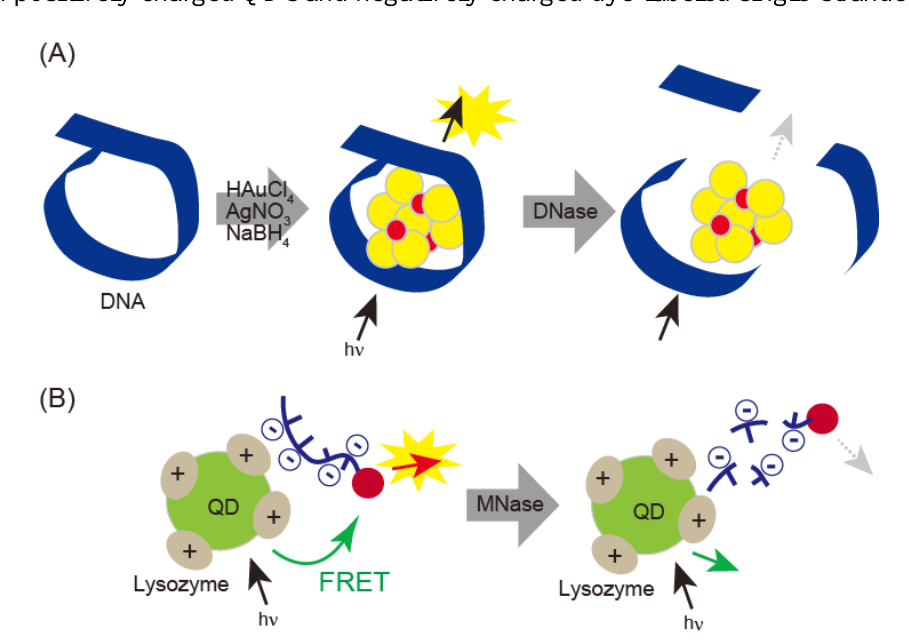
Figure 6. ( A ) DNase I detection of aggregated fluorescent DNA-covered nanoparticles after digestion with DNase I; ( B ) DNase I detection by electrostatic interaction-based FRET between positively charged QDs and negatively charged dye-labeled single-stranded